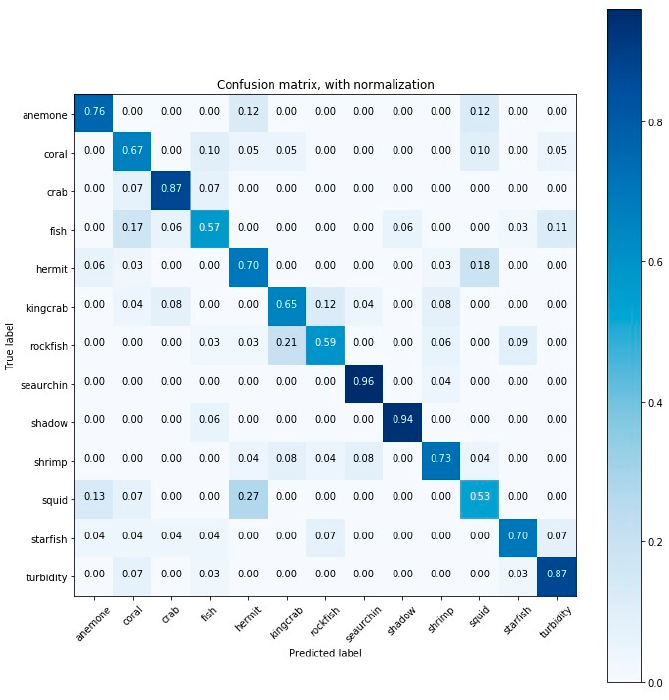
Figure A8. Confusion matrix for the classification results (accuracy) obtained by convolutional neural network (CNN) CNN-1. Sensors 2020 , 20 , 726